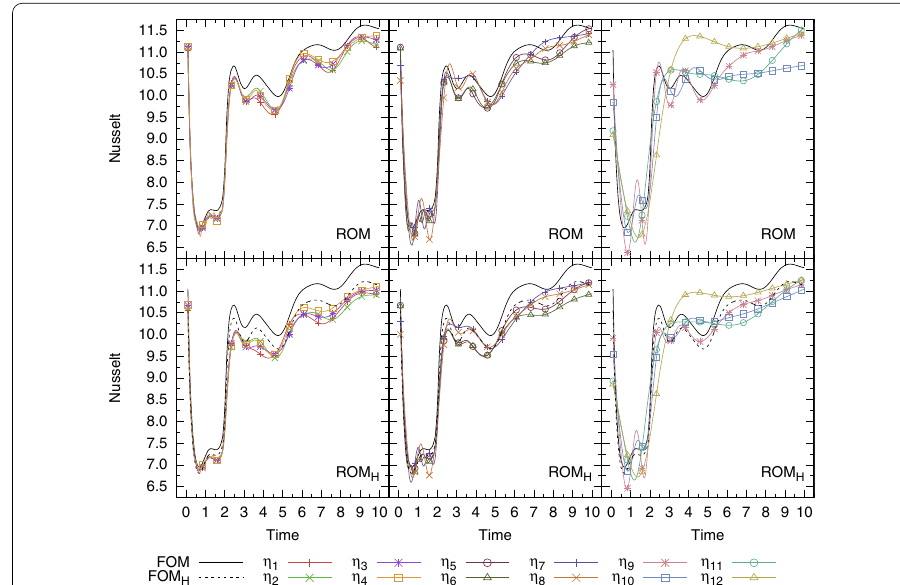
Fig. 5 Nusselt number evolution for the hot wall